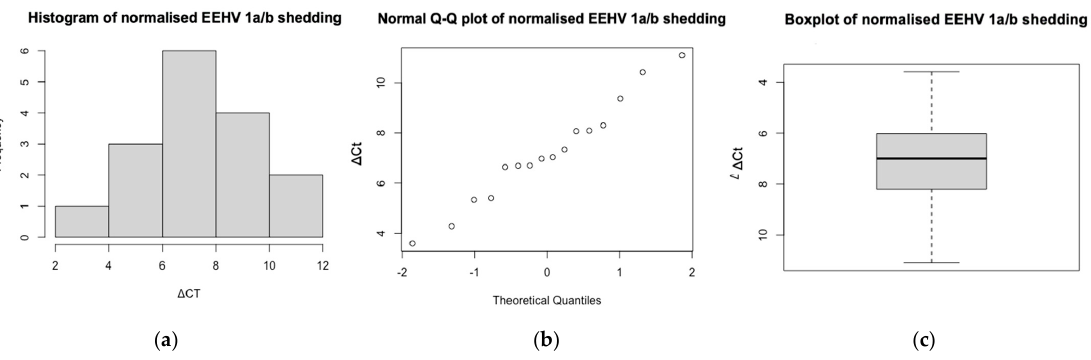
Figure A2. The ( a ) histogram, ( b ) normal Q–Q plot, and ( c ) box plot of the normalised EEHV 1a/b shedding Δ Cts. Both the histogram and normal Q–Q plot exhibited an approximately normal distribution via a bell-shaped curve and alignment of data along the diagonal line, respectively. There were no outliers within the Δ Ct dataset. For the box plot, the y-axis is inverted to visually represent the inverse relationship between qPCR Cts and gene expression. As determined by a Shapiro–Wilk test, there was no evidence to suggest EEHV 1a/b Δ Cts were not normal ( p = 0.9).